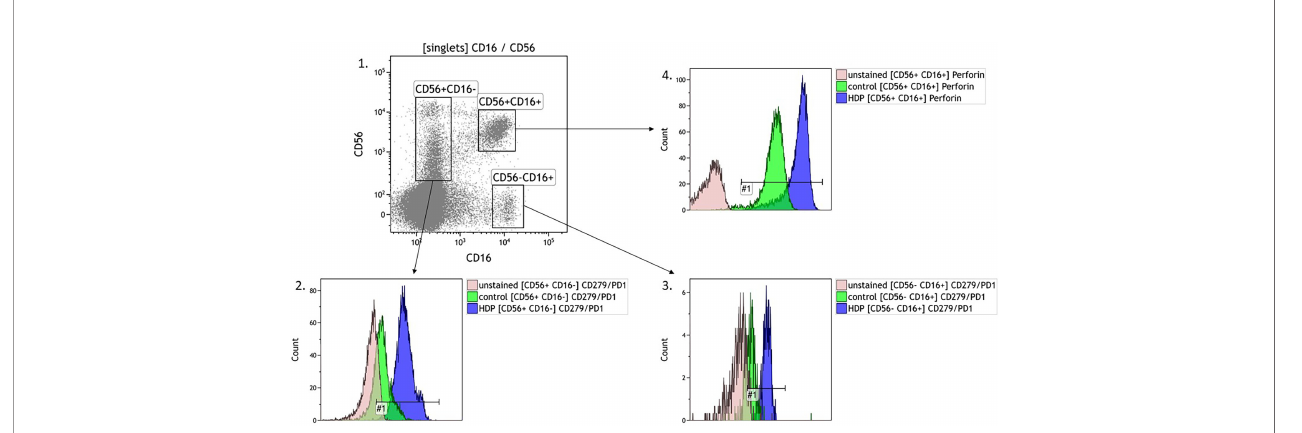
FIGURE 3 | Dot plot analysis, CD16 and CD56 antigens on the NK lymphocyte population [3.1]. Expression of CD279, CD94 and perforin in NK subsets from HDP patients (blue) and healthy control patients (green). The cut-off value [#1] was established for the statistically signi fi cant parameters: [3.2] CD279 on 56 + 16-, [3.3] CD279 on CD56-16+ NK cells, and [3,4] perforin in CD56+16+NK cells, based on the unstained negative sample signal as a reference